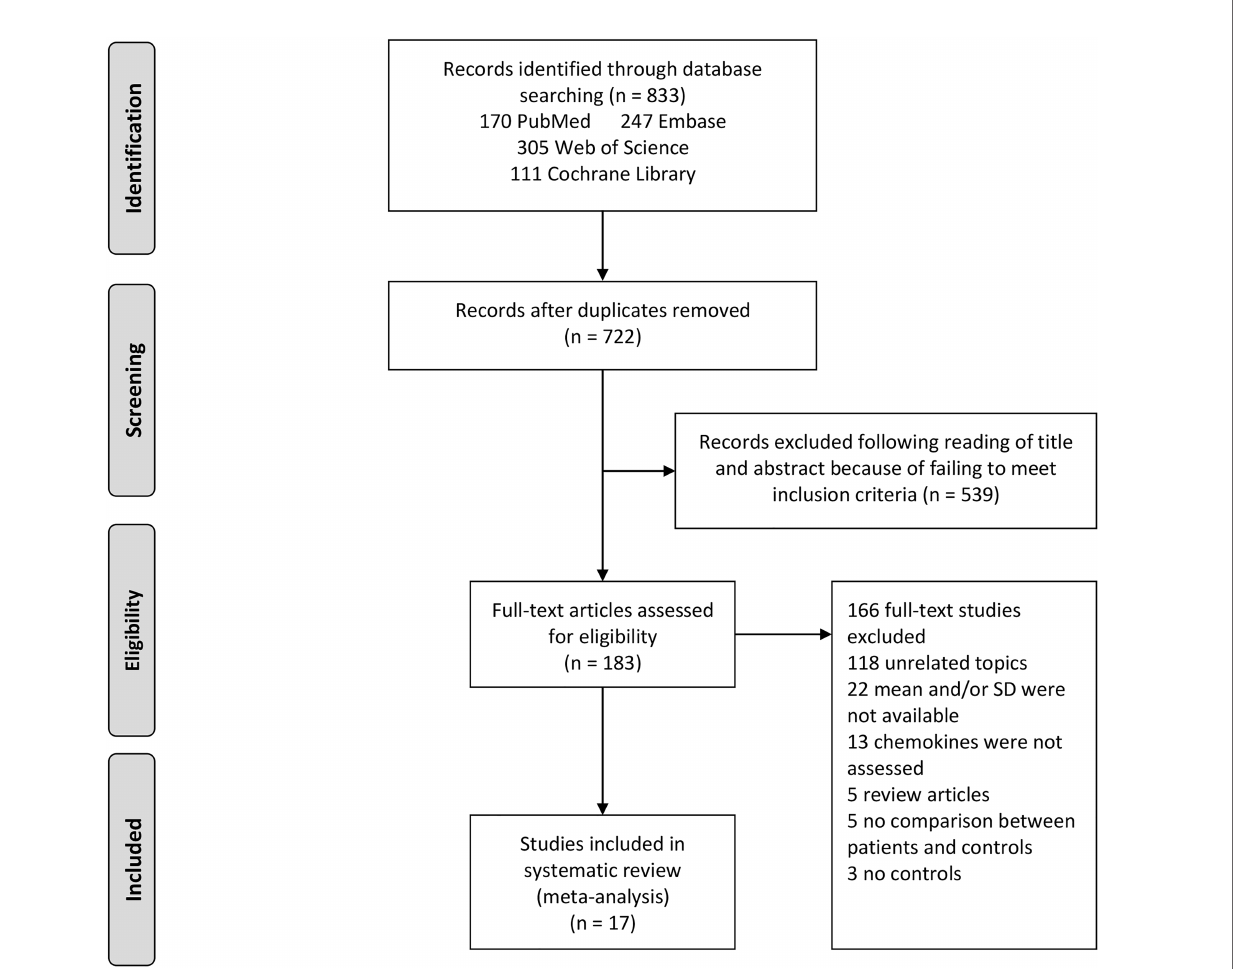
FIGURE 1 | Study selection fl ow chart. A fl ow chart demonstrating the selection process of articles included in the analysis as well as in the qualitative